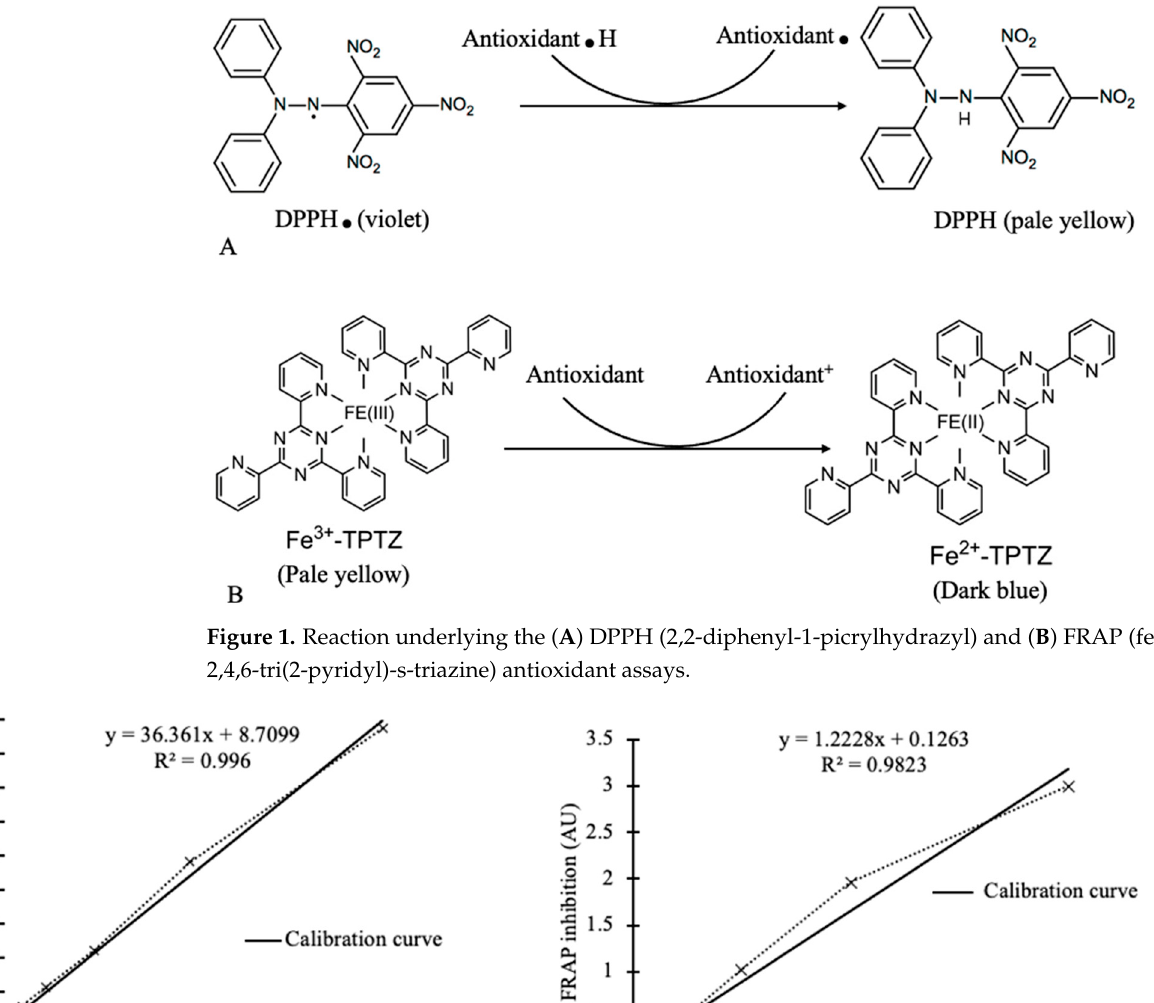
Figure 1. Reaction underlying the ( A ) DPPH (2,2-diphenyl-1-picrylhydrazyl) and ( B ) FRAP (ferric